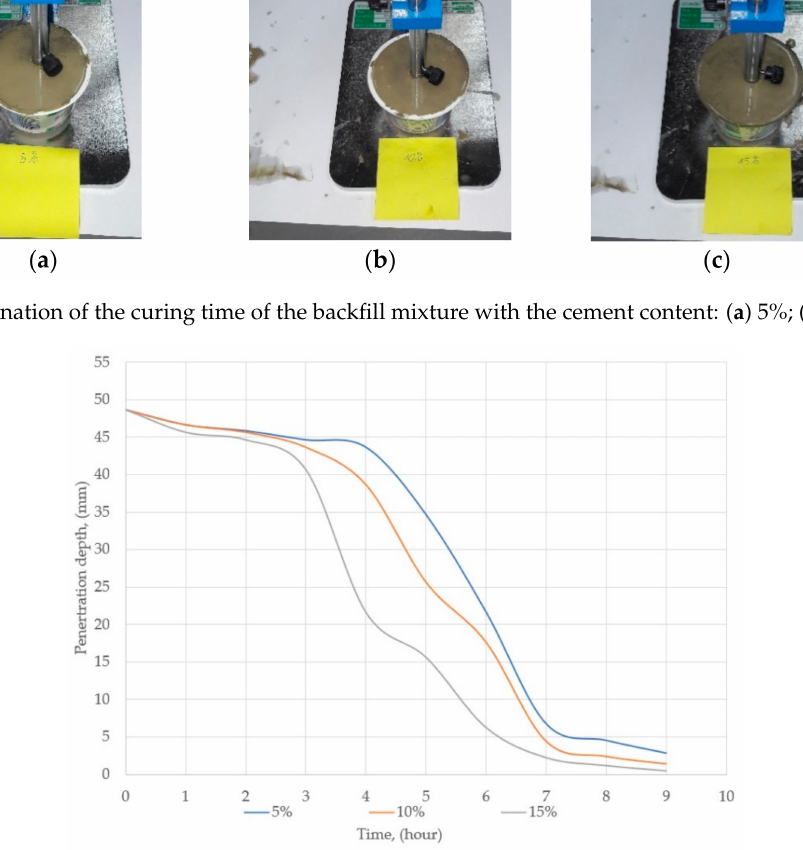
Figure 4. Curing time results for the backfill mixtures, each with a different cement